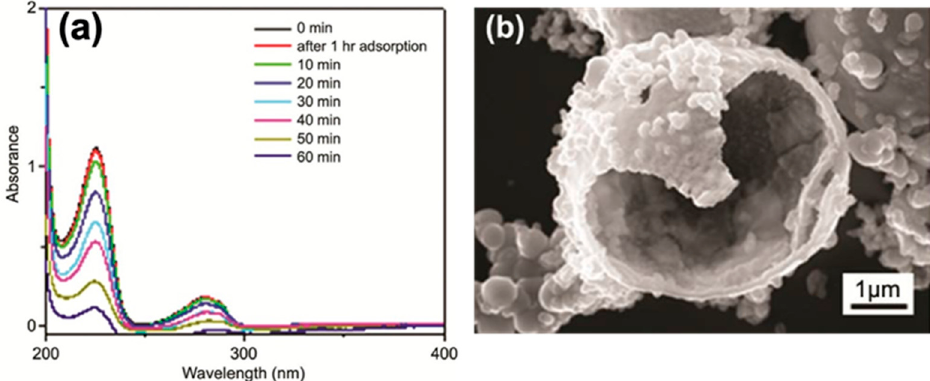
Figure 8. ( a ) Ultraviolet (UV)–visible absorption spectra of the 4-CP containing sample, in the course of the heterogeneous photocatalytic experiment assisted by hollow TiO 2 microspheres as photocatalyst. The TiO 2 has been separated from the aqueous solution of 4-CP by filtration, before recording the absorption spectrum ( b ) FESEM high magnifications micrography of TiO 2 hollow microspheres. Reproduced with permission from ref. [75] http://creativecommons.org/licenses/by-nc- nd/2.5/in/